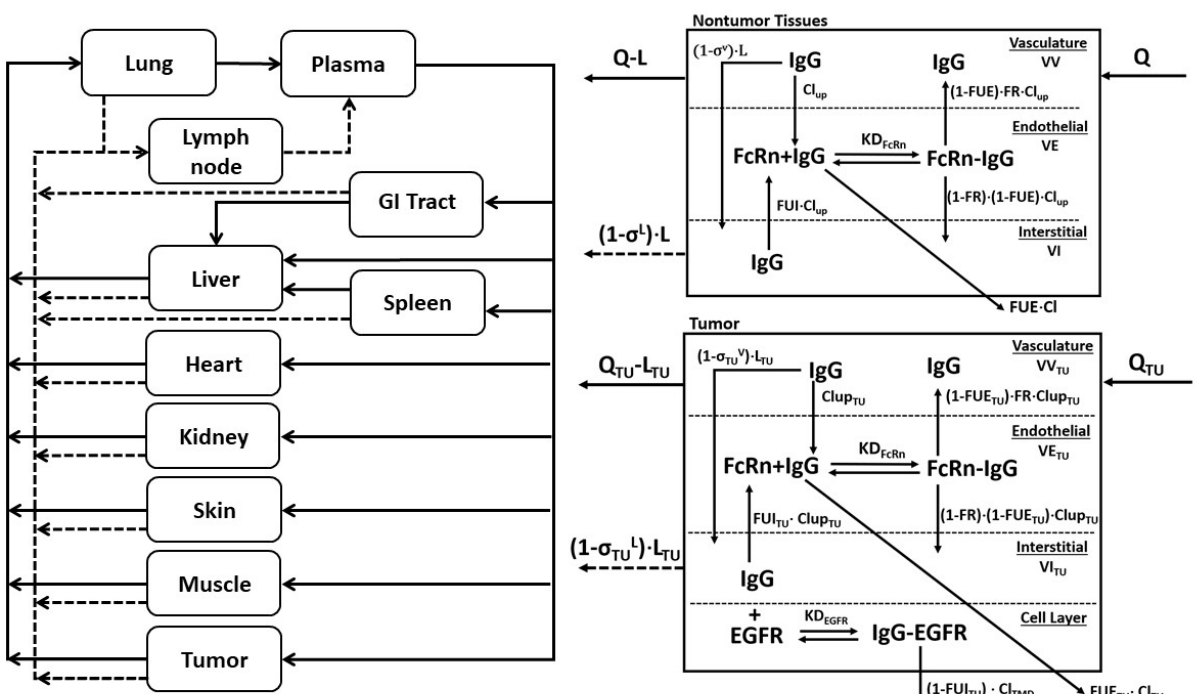
Figure 7. Schematic representation of the PBPK Model: The PBPK model is shown as a schematic diagram with solid lines representing plasma flow to and from tissues and dashed gray lines repre- senting lymph flow. B. Each tissue compartment is composed of three sub-compartments representing vascular, endothelial, and interstitial spaces. Q and L represent tissue plasma and lymph flow, and σ V and σ L represent the vasculature and lymph reflection coefficients. Endosomal uptake is represented as Clup, and endosomal recycling is the product of Clup and the fraction of FcRn bound mAb that is returned to the vasculature, abbreviated as FR. KD FcRn is the equilibrium dissociation constant for FcRn-mAb binding. Organ-specific elimination of unbound mAb in the endothelial space (FUE) is denoted as Cl. C. The tumor sub-compartment structure is shown. A 4th layer representing the cellular fraction is added, allowing the antibody to bind its target antigen (i.e., EGFR) with the observed equilibrium dissociation constant (KD EGFR ) with bound antigen eliminated through receptor internalization and degradation (Cl TMD ).